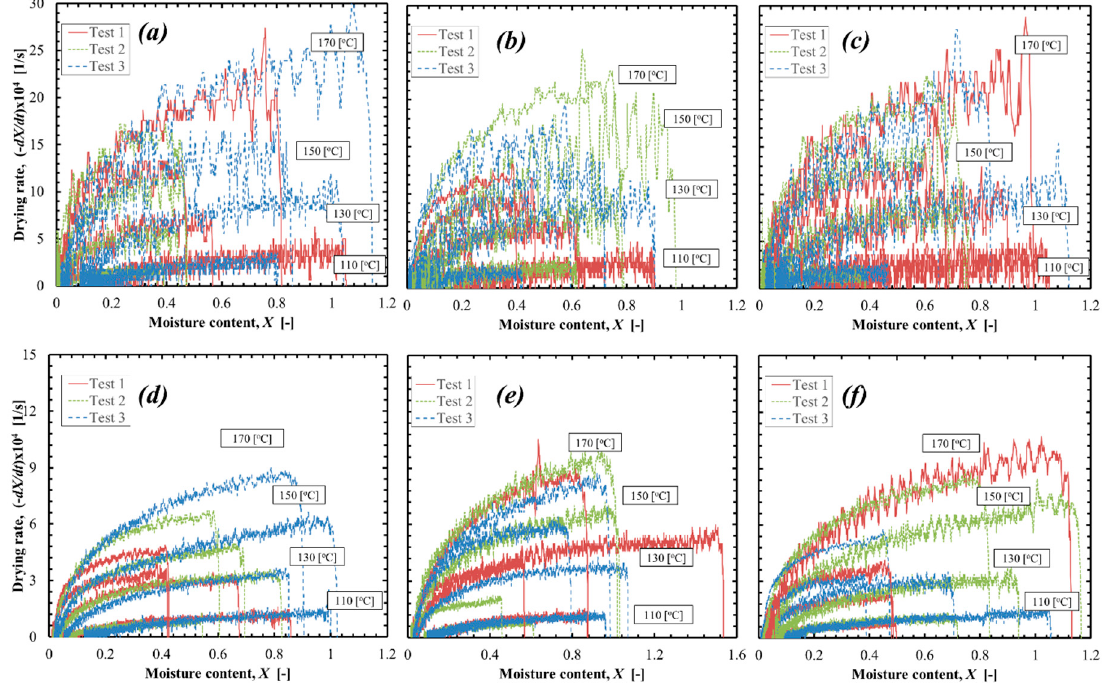
Figure 10. Drying rate curve plot for: ( a ) T1 5 mm; ( b ) T2 5 mm; ( c ) T3 5 mm; ( d ) T1 10 mm; ( e ) T2 10 mm; and ( f ) T3 10 mm samples.